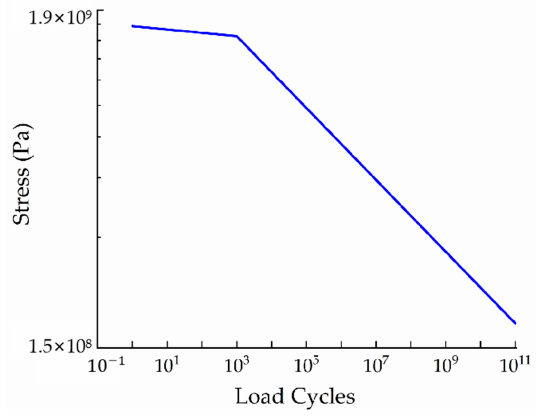
Figure 15. 20CrNiMo S-N curve.